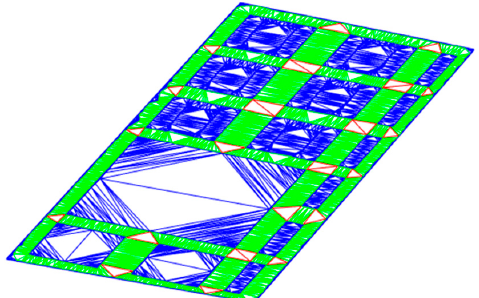
Figure 4 . Triangulation 𝑻 𝑩 , where each triangle is coloured according to the number of building blocks that are in contact with its vertices. Red triangles are in contact with 3 blocks (intersections), green triangles are in contact with two blocks (streets) and blue triangles are in contact with only one block (building blocks).